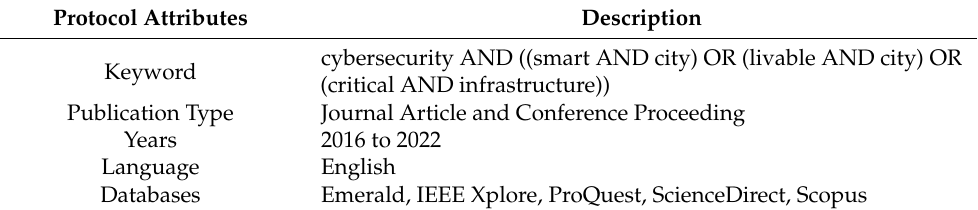
Table 1. Searching strategies.